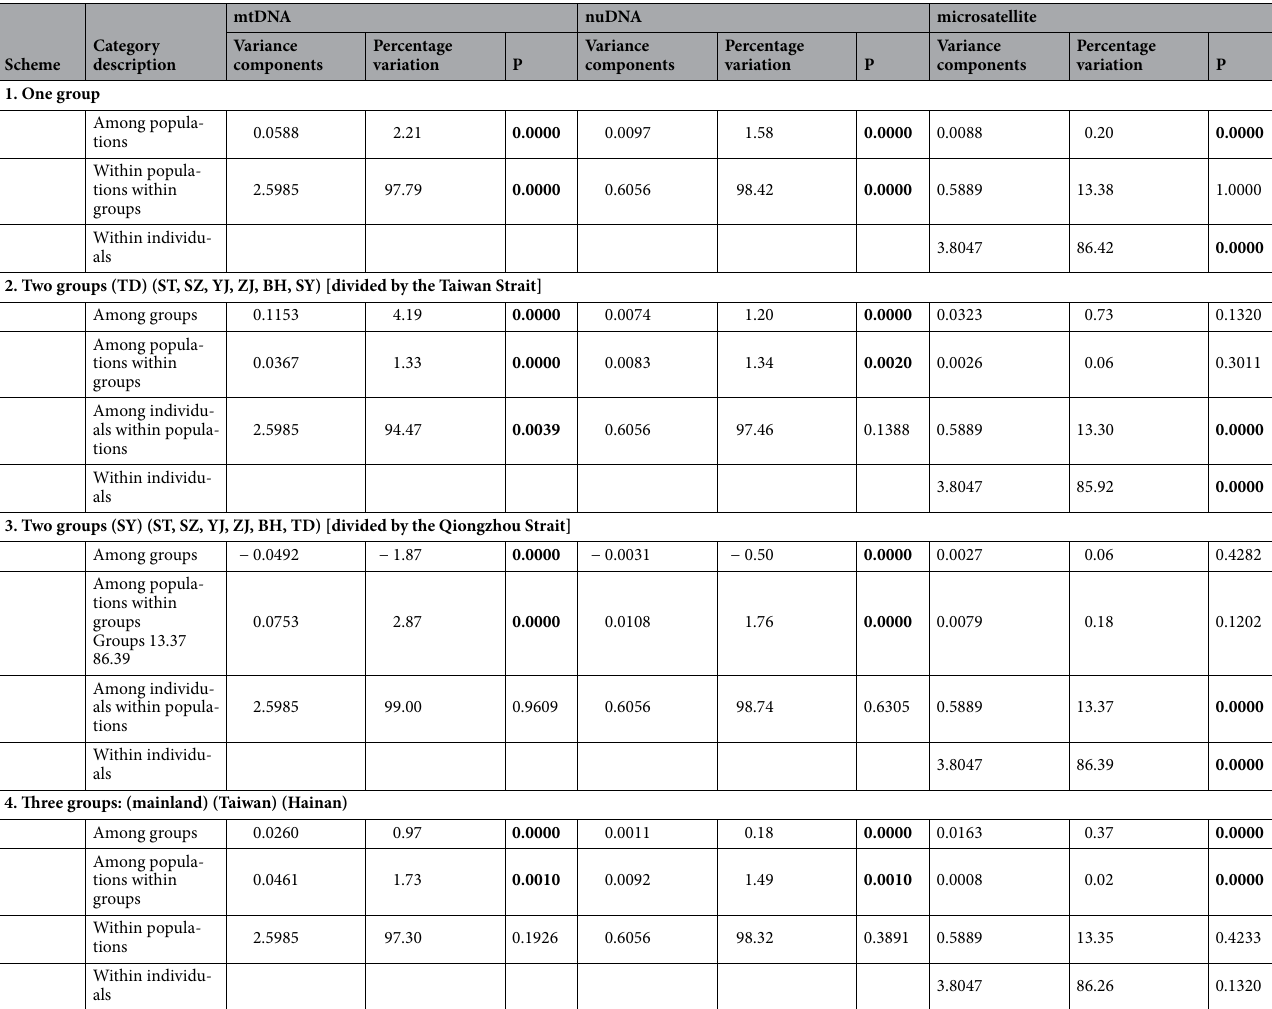
Table S4. The pairwise F ST values, with an average of 0.042(10 –2 ), ranged from − 0.002 (between ZJ and YJ) to 0.014 (between SY and TD), and the R ST values, with an average of 0.009, ranged from − 0.014 (between TD and SZ) to 0.040 (between ZJ and TD) (Supplementary Table S5). The pairwise F ST values between the TD population in Taiwan and other populations were relatively large in all pairwise comparisons, and differentiation between ST, ZJ, BH, and SY was significant (Supplementary Table S5). The results showed a nonsignificant correlation within IBD analyses between genetic differentiation and geographic distance using microsatellite DNA data (r = 0.618, p = 0.031). AMOVA showed that most of the genetic diversity was within individuals, i.e., one group (86.42%), two groups (Scenario I, 85.92%), two groups (Scenario II, 86.39%), and three groups (Scenario III, 86.26%) (Table 2). When the populations were divided into two groups (Scenario I), two groups (Scenario II), and three groups (Scenario III) according to the geographical barriers, only 0.73%, 0.06%, and 0.37% of the total variation was found among the groups, respectively. We used the Bayesian model-based clustering algorithm implemented in STRU CTU RE 2.3.3 software to assign individuals into populations by estimated individual admixture proportions and to explore different numbers of populations K to the population structure based on microsatellite data. The most likely number of clusters was determined by Structure Harvester, which indicated that all seven populations were separated into two distinct genetic clusters (K = 2, Ln P(K) = − 172.360; Stdev LnP(K) = 27.976; Delta K = 6.036) (Supplementary Table S6). Although the results of the STRU CTU RE analysis supported K = 2, all sampled individuals exhibited admixture among two clusters with roughly equal contributions (Fig. 5). Microsatellite DNA data were used to provide a platform for data visualization and construction of a heatmap representing the allele frequency for all 13 loci in the 7 populations, as presented in Fig. 6. The interpretation of the color intensity was as follows: the relationship between the color and the allele frequency is given by the color bar on the right. The firebrick color indicates the highest value of allele frequency. The heatmap of allele distribution and frequency across